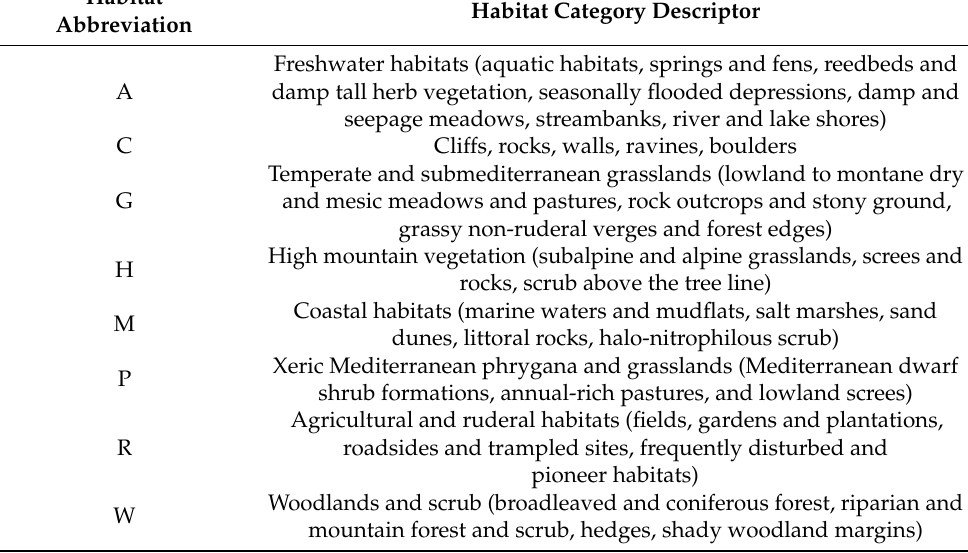
Table 4. Habitat categories used in the analyses, as described in [4]. Coastal habitats (M) were not found in the study